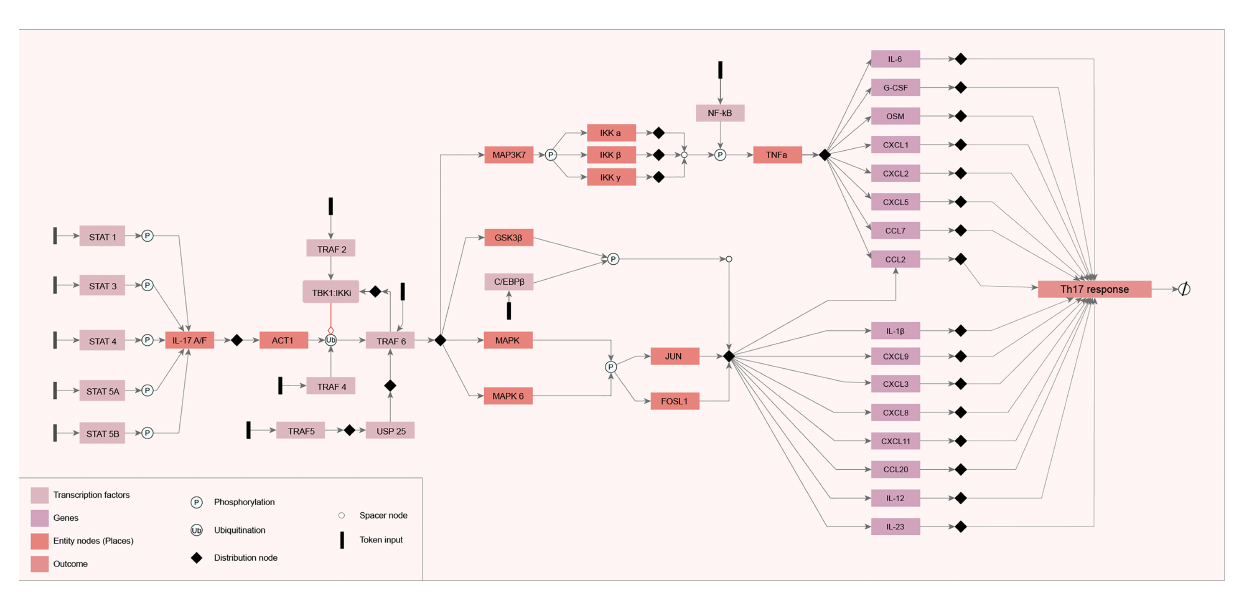
FIGURE 1 | Diagram of the constructed network. The network diagram was constructed using the yEd Graph Editor according to the mEPN notation, described by Livigni et al. (2018), using the information obtained from the search carried out in the literature. The components (genes) in the IL-17 gene regulatory network (GRN) are represented by rectangles connected by arrows that indicate the molecular interactions found during the literature review step. System start nodes (transcription factors) are represented by colored rectangles in black. The GRN output signal is represented in the rectangle on the right side of the